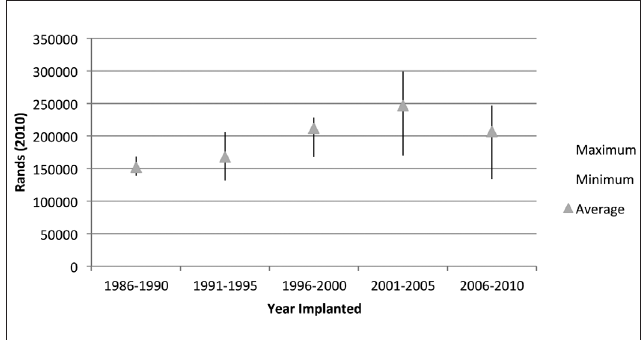
Fig. 1. Cochlear implant system costs between November 1986 and June 2010.